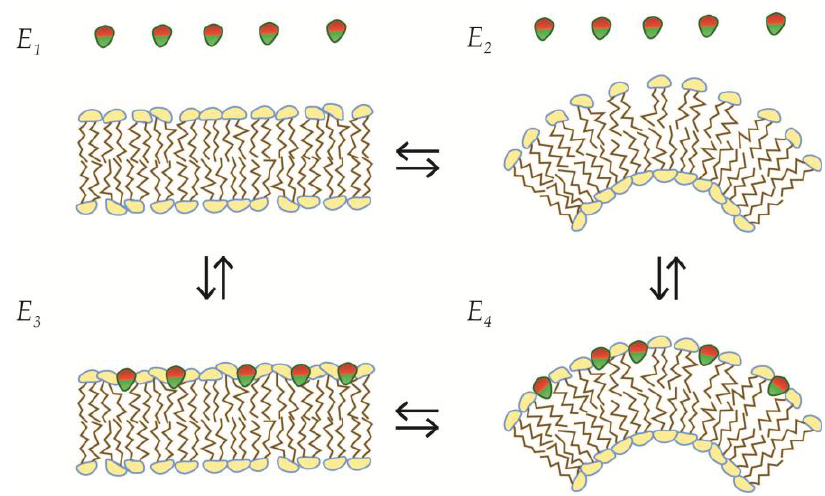
Figure 3. Dual curvature interaction; MCS and MCG by AIMs. The dual nature of curvature stabilizing proteins or motif exemplified with insertion of AIMs, which are depicted with a hydrophobic face ( green ) and a hydrophilic face ( red ).